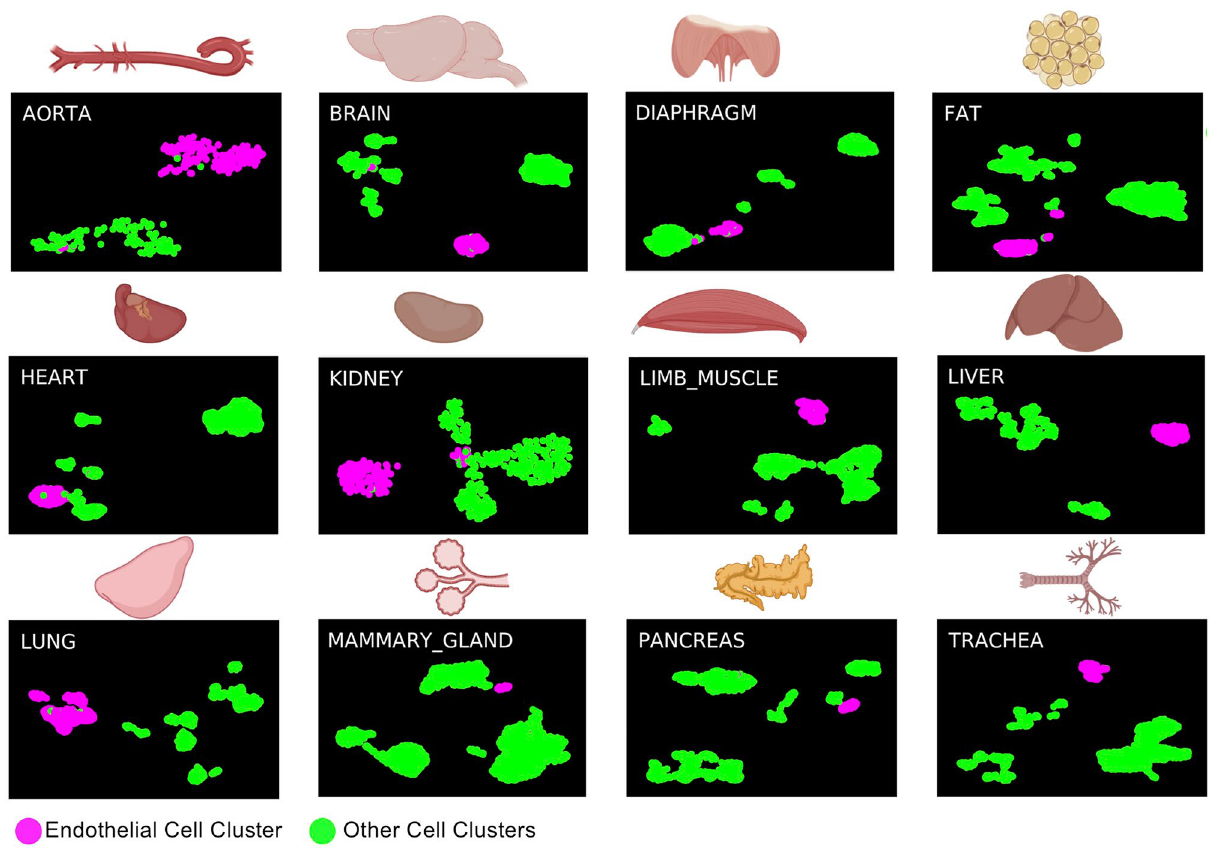
Figure 1. sc-RNA-seq analysis identifies adult endothelial cells in Tabula Muris dataset. UMAP plots showing the clustering analysis result for each of the indicated tissues. Figure was made in BioRender—https:// biore nder.